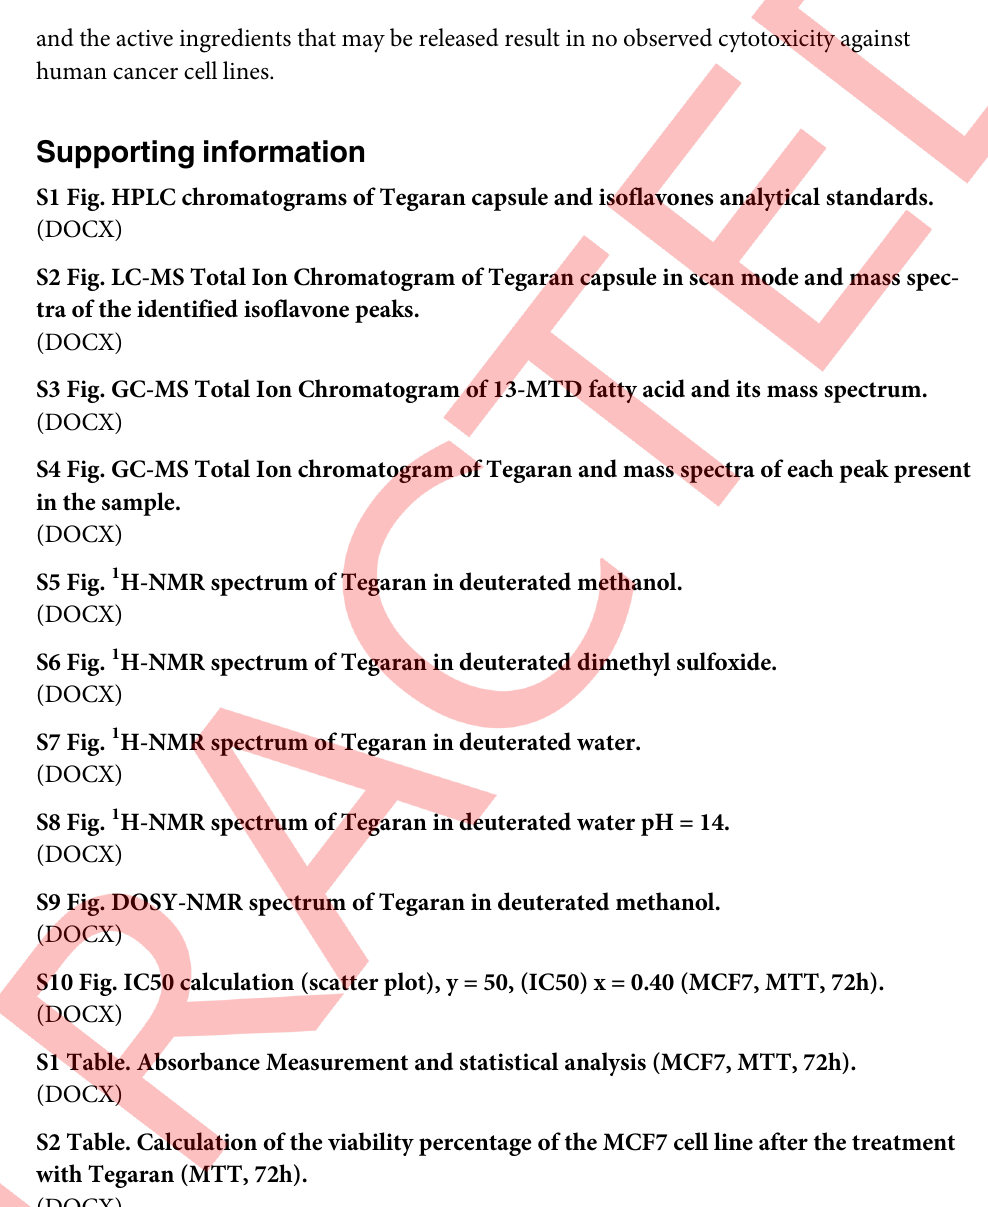
S1 Table. Absorbance Measurement and statistical analysis (MCF7, MTT, 72h). S2 Table. Calculation of the viability percentage of the MCF7 cell line after the treatment with Tegaran (MTT, 72h). S3 Table. Calculation of the cytotoxicity percentage of Tegaran against MCF7 cell line (MTT,